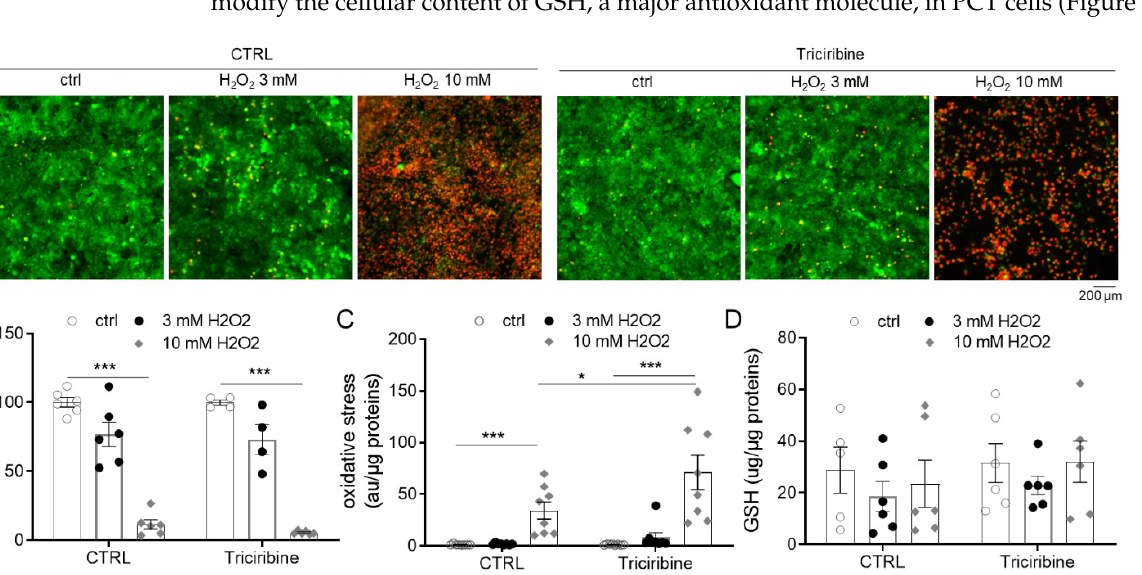
Figure 6. Reversibility of triciribine treatment. Akt phosphorylation and myxothiazol induced cell death were assessed after 24 h triciribine treatment (1 µM) followed by 2 washes and either a 48 (r48 h) or 72 (r72 h) h recovery period. Control cells were stopped at 48 h after media change. ( A ) Phos- phorylation of Akt on both Ser(473) and Thr(308) sites were assessed by western blot as well as total Akt proteins. Representative WB and related ratio analysis of p-Akt/Akt band intensities values along with mean ± SEM. n = 3. ( B ) Control or 48 h recovery cells were treated for 24 h with 1 µM myxothiazol and survival rate was evaluated using a live/dead fluorescence assay. Scatter plot rep- resents individual values along with mean ± SD. n = 12. *** p < 0.001. 3. Discussion The success of kidney transplantation is seriously compromised by the nefarious ef- fects of I/R, which is mandatory in the surgical procedure. Although a growing number of studies emphasize the pathological mechanisms of renal I/R injury, a satisfactory strat- egy to avoid undesirable effects of I/R has yet to be found. In this way, numerous studies